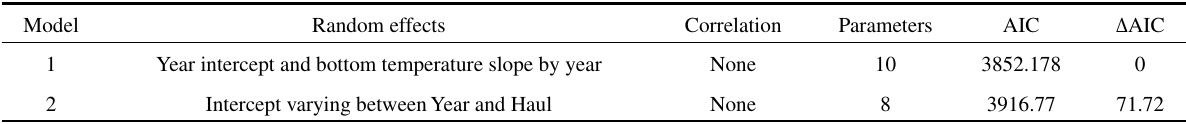
Table S2. – Selection of random effects with potential fecundity as a dependent variable. First, optimal random effects were tested AIC, Akaike information criterion. Note: The covariates in all these models (i.e. the fixed structure) are the fork length, condition factor (K), gonadosomatic index (GSI) and bottom temperature. The ∆AIC of random intercept and slope model is lower compared with random intercepts. However, the likelihood ratio test was performed to compare